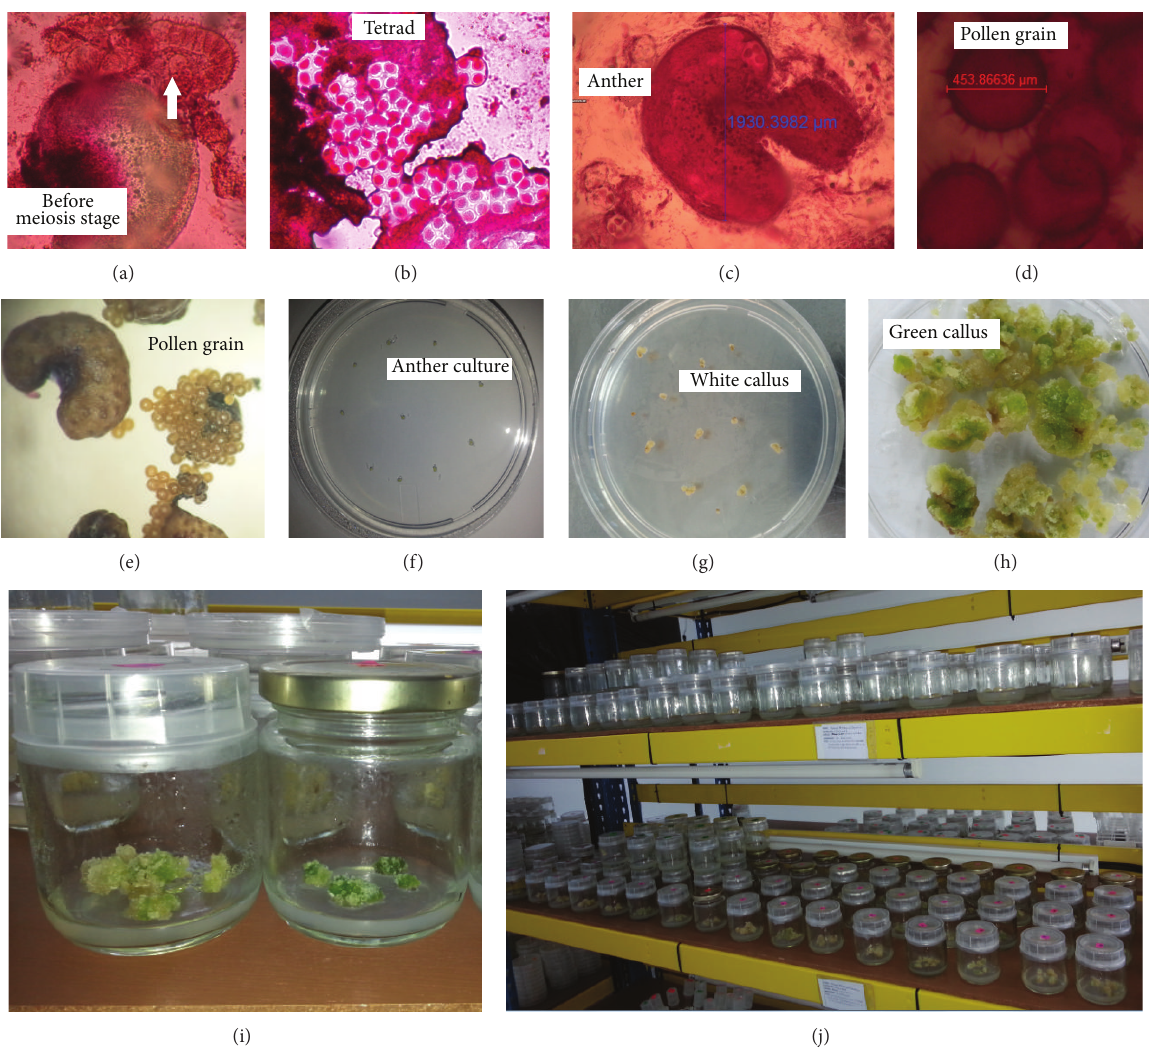
Figure 2: (a) Anther before meiosis stage, (b) Tetrad stage, (c) anther length, (d) pollen grain length, (e) mature anther and pollen grain, (f) anther culture in petri dish contain callus media, (g) white callus induction after 8 weeks (first subculture), (h) green callus after 6 weeks (second subculture), (i) and (j) callus in